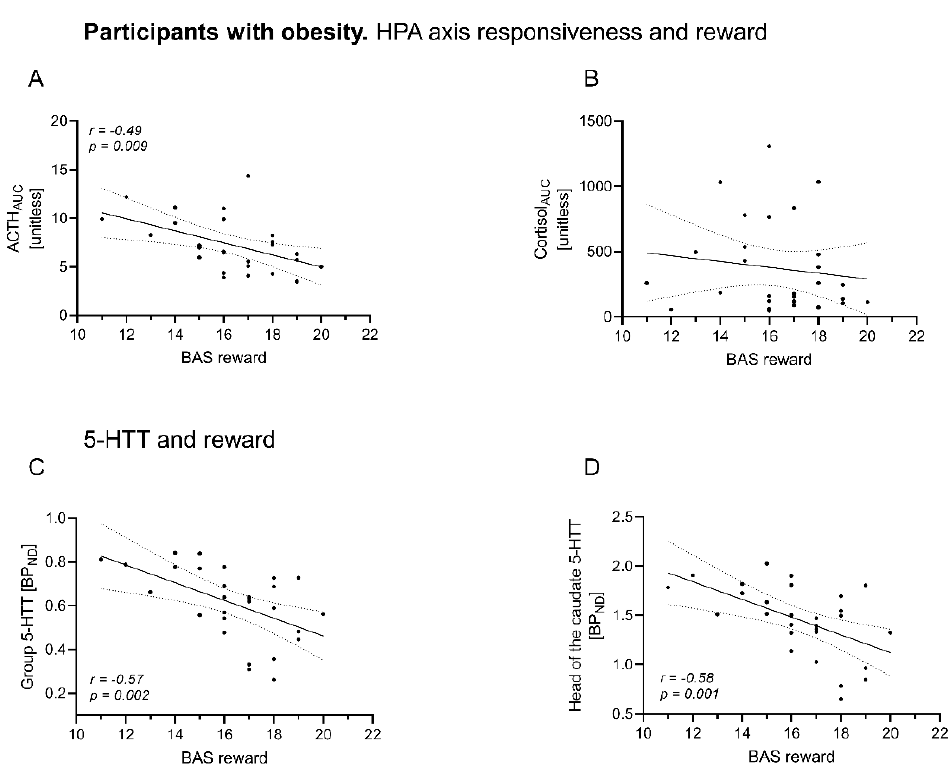
Figure 4. Reward sensitivity in relation to HPA axis responsiveness or 5-HTT BPND of dedicated